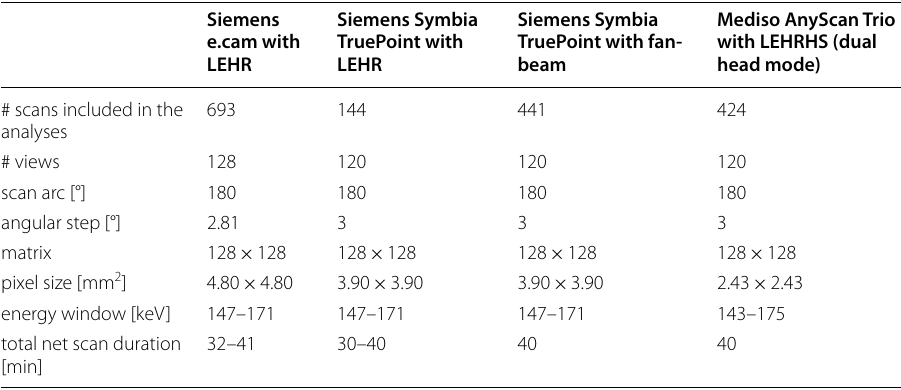
Table 1 SPECT acquisition